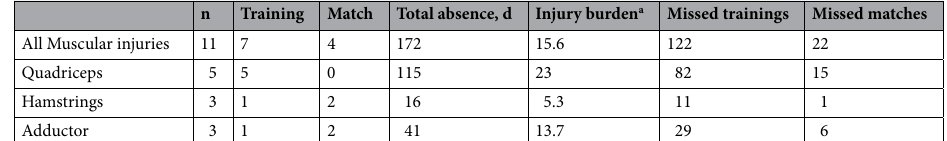
Table 2. Descriptive statistics for the sectorial position.